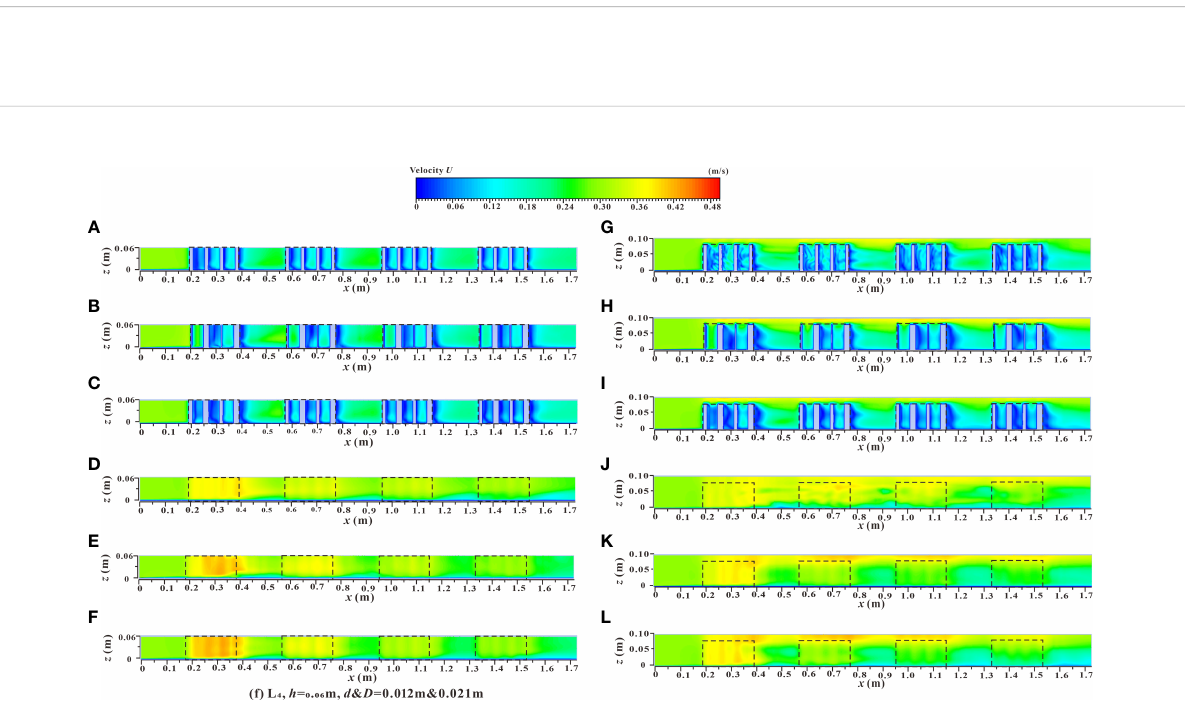
FIGURE 10 Spatial distribution of velocity contours of yz sections under different submerged states. (A) L 3 , h = 0.06 m, d & D = 0.012 m & 0.012 m, non- submerged vegetation, (B) L 3 , h = 0.06 m, d & D = 0.003 m & 0.021 m, non-submerged vegetation, (C) L 3 , h = 0.06 m, d & D = 0.012 m & 0.021 m, non-submerged vegetation, (D) L 4 , h = 0.06 m, d & D = 0.012 m & 0.012 m, non-submerged vegetation, (E) L 4 , h = 0.06 m, d & D = 0.003 m & 0.021 m, non-submerged vegetation, (F) L 4 , h = 0.06 m, d & D = 0.012 m & 0.021 m, non-submerged vegetation, (G) L 3 , h = 0.10 m, d & D = 0.012 m & 0.012 m, submerged vegetation, (H) L 3 , h = 0.10 m, d & D = 0.003 m & 0.021 m, submerged vegetation, (I) L 3 , h = 0.10 m, d & D = 0.012 m & 0.021 m, submerged vegetation, (J) L 4 , h = 0.10 m, d & D = 0.012 m & 0.012 m, submerged vegetation, (K) L 4 , h = 0.10 m, d & D = 0.003 m & 0.021 m, submerged vegetation, (L) L 4 , h = 0.10 m, d & D = 0.012 m & 0.021 m, submerged vegetation.